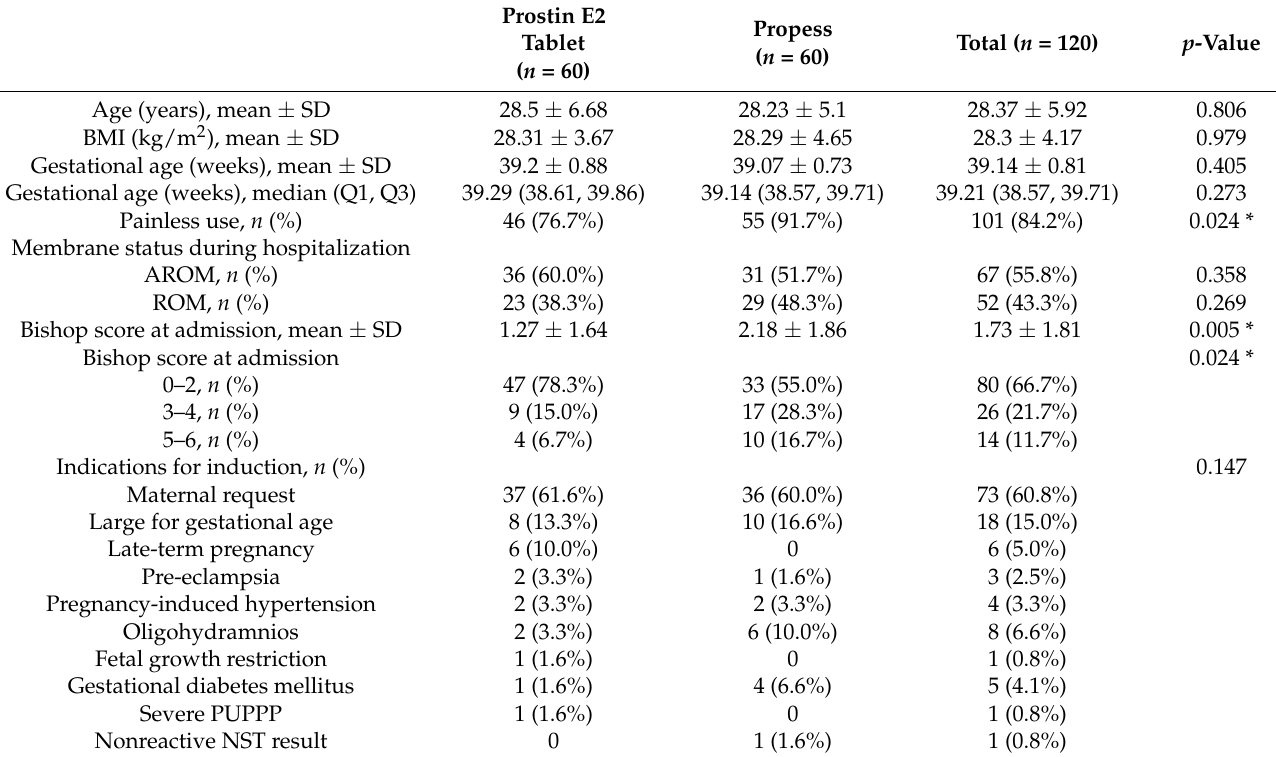
Table 1. Demographic and baseline characteristics.